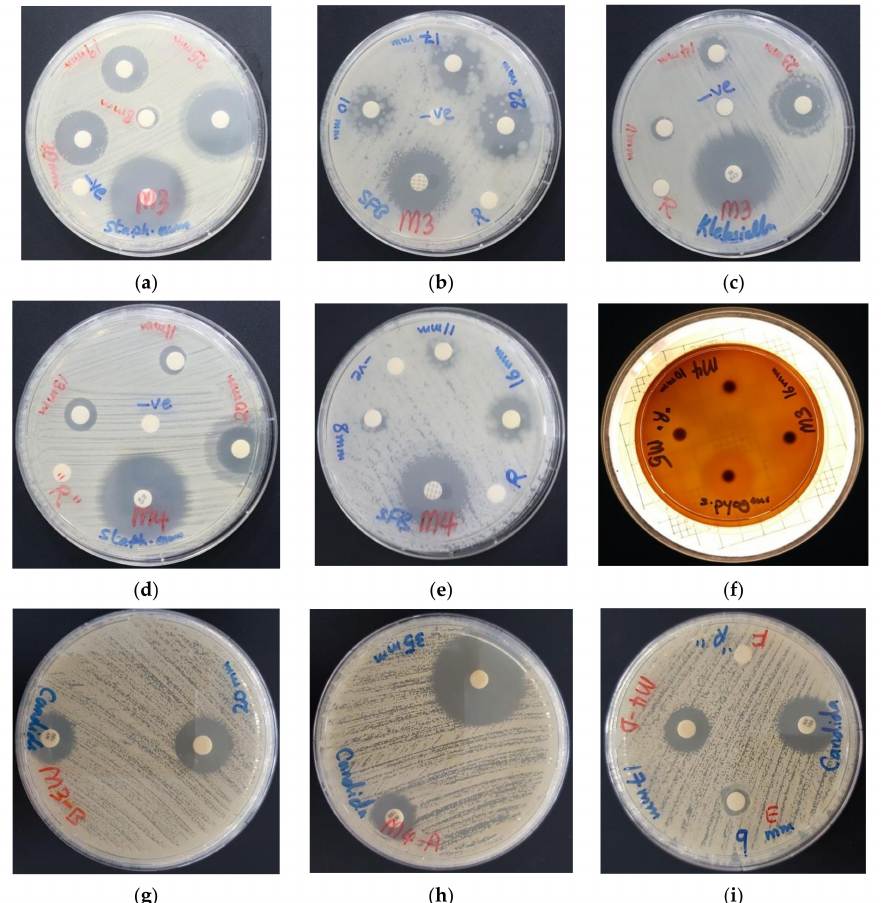
Figure 6. Antimicrobial disc dilution assay of biocomplexes with positive controls (antibiotic). From left to right: AV-PVP-I 2 against ( a ) S. aureus ATCC 25923 ; ( b ) P. aeruginosa WDCM 00026; ( c ) B. subtilis WDCM 00003 . From ( d , e ): AV-PVP-I 2 -NaI against ( d ) S. aureus ATCC 25932 ; ( e ) B. subtilis WDCM 00003 ; ( f ) AV-PVP-I 2 , AV-PVP-NaI and AV-PVP-NaI against S. pyogenes ATCC 19615 . From ( g – i ): Susceptibility of C. albicans WDCM 00054 towards ( g ) AV-PVP-I 2 (25 µ g / mL); ( h ) AV-PVP-I 2 -NaI (50 µ g / mL); ( i ) AV-PVP-I 2 -NaI (D = 6 µ g / mL, E = 3 µ g / mL, F = 1.5 µ g /